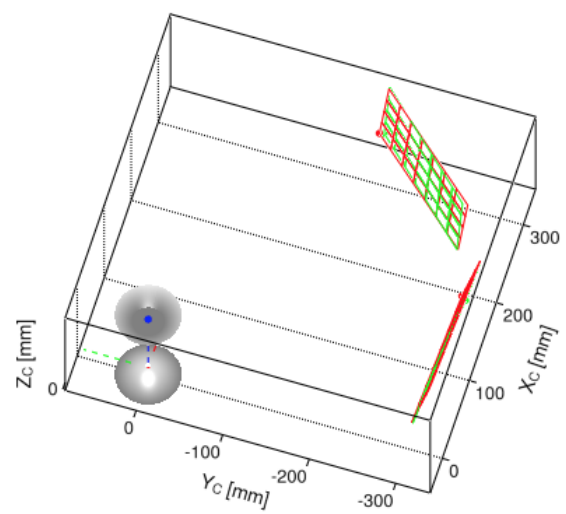
Figure 24. Visualization of estimated 3D poses for some chessboard patterns using the real-life omnistereo rig. Color annotations: ground-truth poses (green), estimated triangulated poses